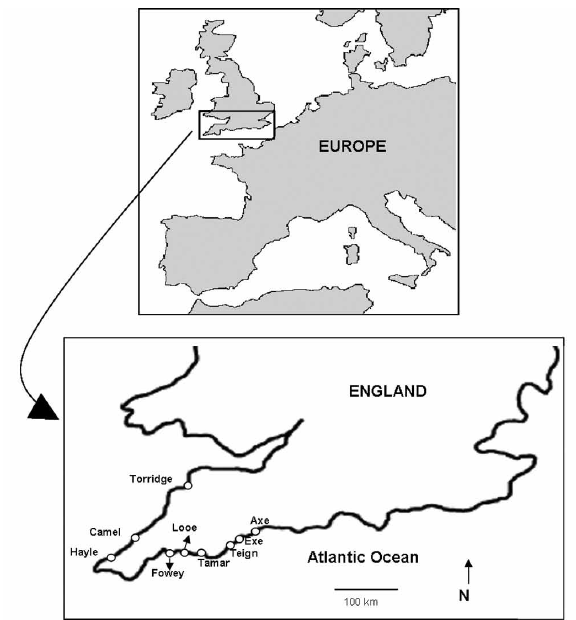
Fig . 1. – Locations of sampling sites in the UK coast. Axe, 50°42’23.81”N, 3° 3’31.72”W; Exe, 50°37’36.33”N;